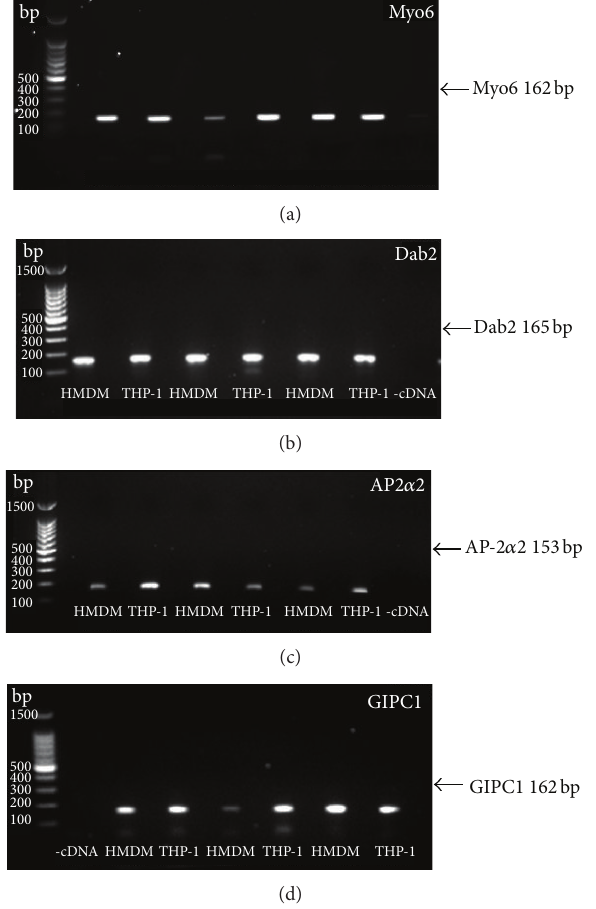
Figure 1: Expression of mRNA for Myo6 and related proteins in THP-1 macrophages and HMDM. Total RNA was extracted from THP-1macrophages(3separatelysates)andHMDM(obtainedfrom three individual donors). PCR was used to amplify gene products for Myo6 (a), Dab2 (b), AP-2 𝛼 2 (c), and GIPC1 (d). Products were visualised on a 1.2% agarose gel containing 0.01% ethidium bromide